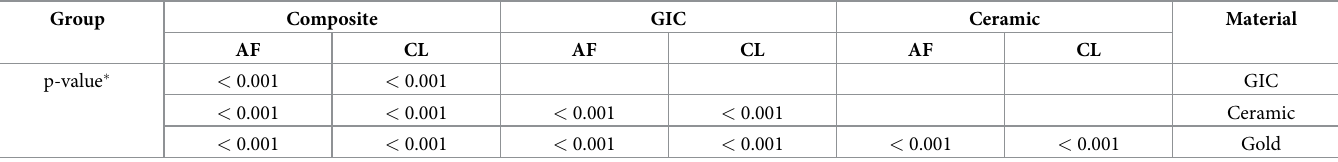
Table 4. Intragroup comparison of p-values between the median abrasion of used restoration materials � .